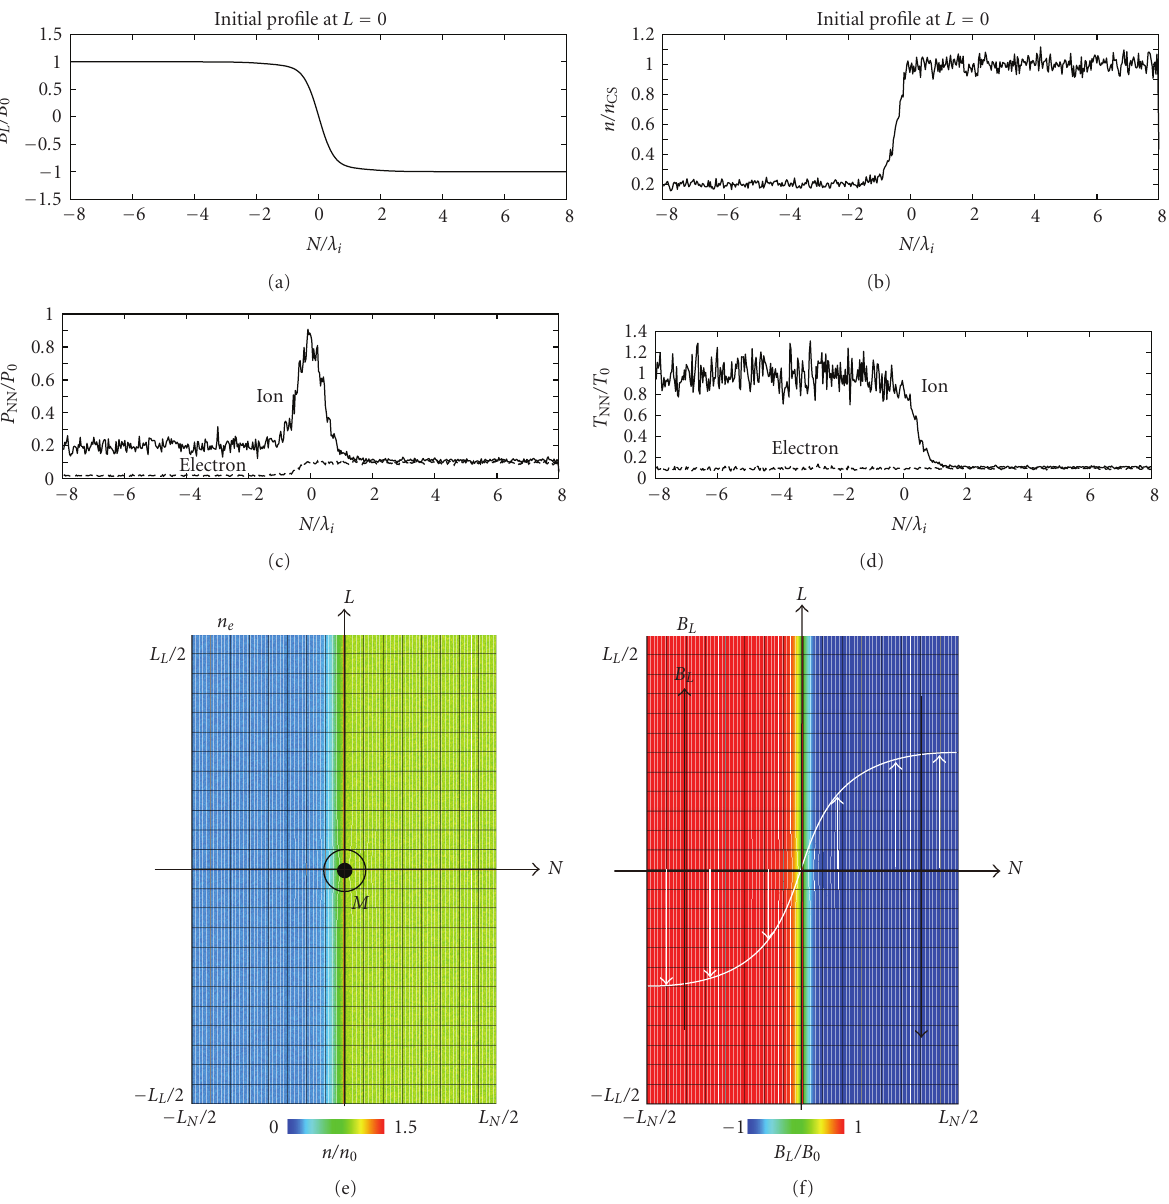
Figure 2: The initial configuration used in this study. From (a) to (d), the one-dimensional cuts of the L component magnetic field B L , the electron number density n e , the ion and electron pressure tensor components P i ,NN (solid) and P e ,NN (dashed), and the ion and electron temperature tensor components T i ,NN (solid) and T e ,NN (dashed), respectively. (e) and (f) show the two-dimensional contours of the electron density and the B L component. The coordinate system is depicted in (e). White arrows in (f) depict how the shear flow is given in this study. Black arrows in (f) show the directions of the magnetic